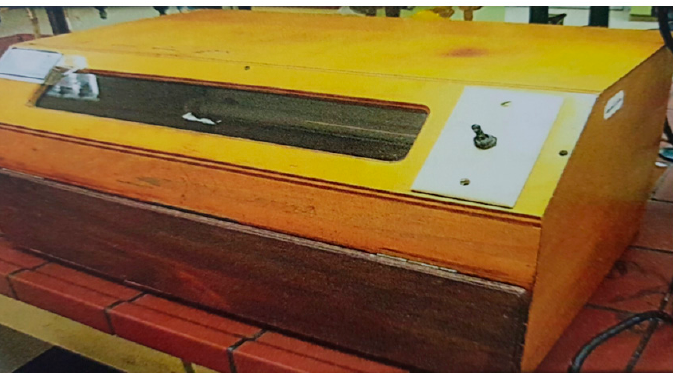
Fig. 1. The wooden chamber containing the UV lamp in its ceiling and the bacteria sample placed at the